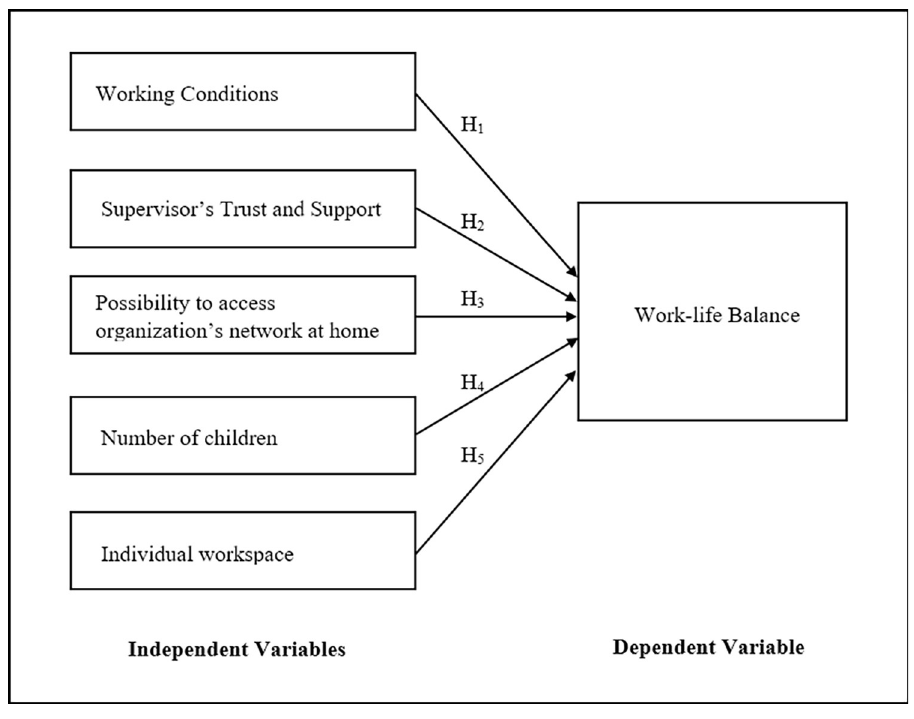
Fig 1. Conceptual